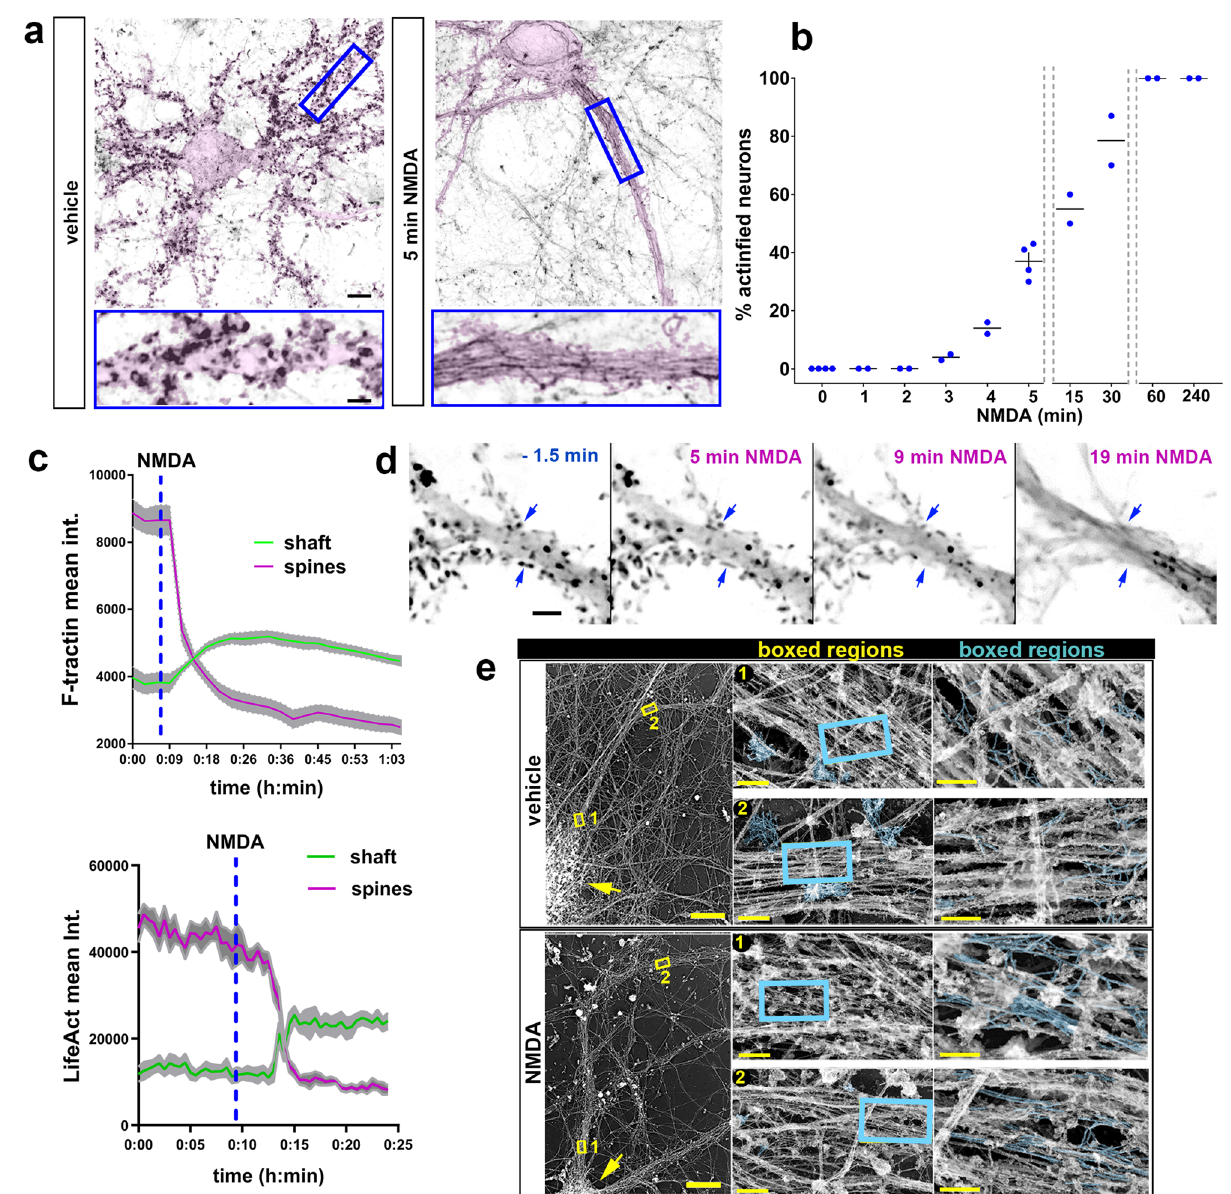
Fig. 2 | Rapid actini fi cation induced by sub-lethal hyperactivation of NMDA receptors: time course and ultrastructure. a Neurons expressing membrane- tagged GFP, to emphasize morphology (pink highlight), and stained with Alexa- Fluor-647-phalloidin to monitor F-actin (reverse grayscale). Neurons fi xed after 5minincubationwithvehicle(left)orwith50 μ M NMDA(right).Insetsbelowshow enlargedregions boxedin. Scalebars,8 µ m (above);2.8 µ m (below). b Time course ofactini fi cation; n =4independentexperimentsfor0and5min; n =2independent experiments for all the other time points. c Examples of two representative time courses where either mApple-F-tractin or Lifeact-mRFP intensity were monitored over time in an individual dendrite shaft (green line) vs the adjacent spines (magenta line) during NMDA-induced actini fi cation. Plotted lines represent mean±SEM from regions of interest (ROIs) taken across different portions of the same dendrite and different spines of a single neuron. d Time-lapse montage of a dendritic region expressing Lifeact-mRFP at selected time points before and after